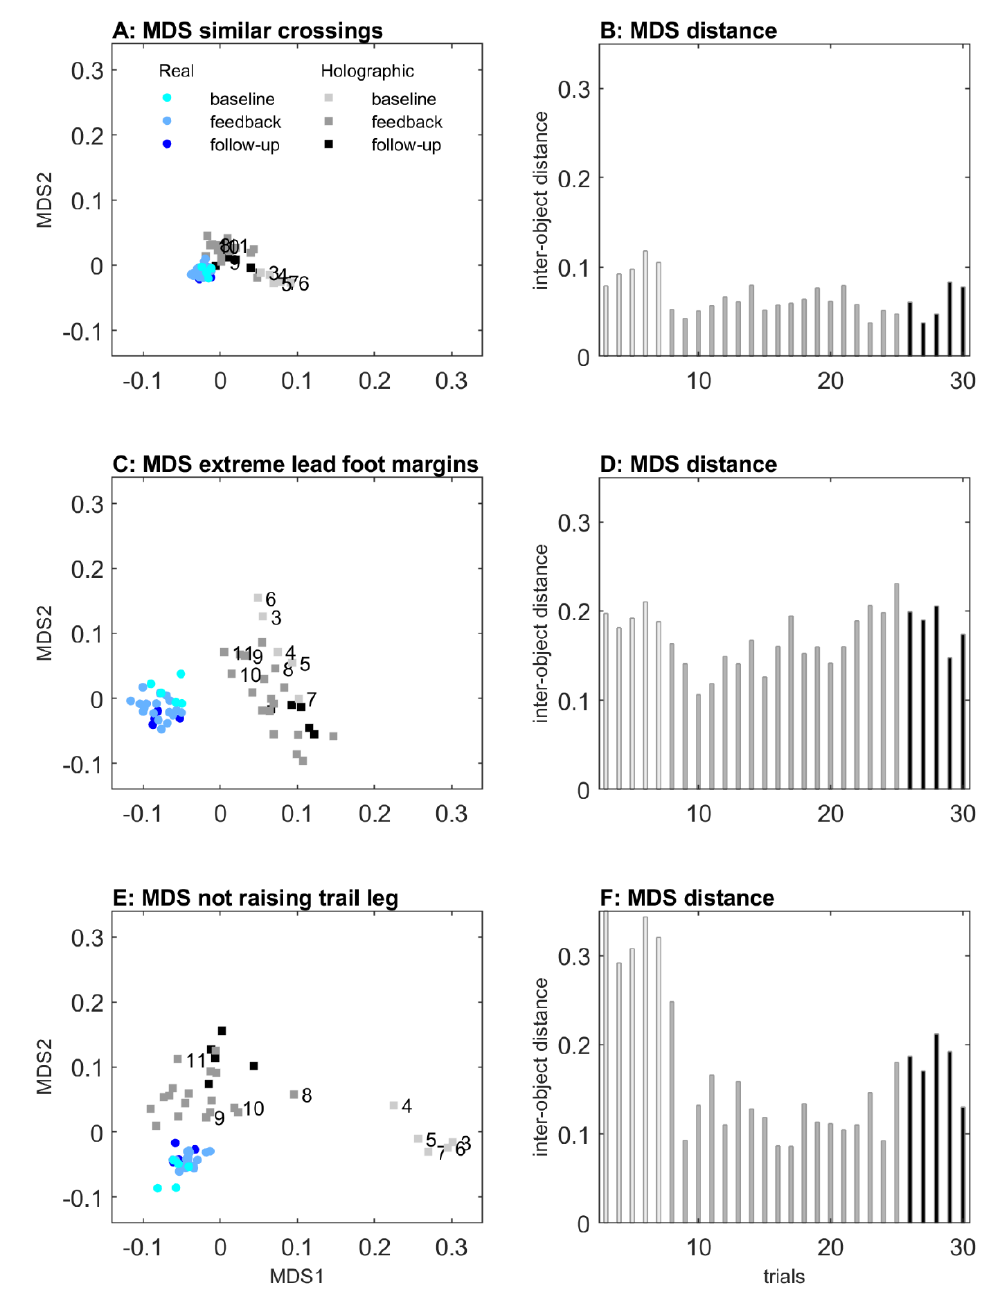
Figure 7. MDS representation of 2 blocks of trials 3 to 30 with real and holographic obstacles, derived from the foot clearances and maximum step heights of both feet from all 12 participants. Panel ( A ) shows participants identified in Experiment 1 as those with similar crossing maneuvers for real and holographic obstacles (participants 2, 3, 5, 6, 9, and 12). Panel ( C ) shows participants identified in Experiment 1 as those with exceptionally high lead-foot crossings (participants 4, 7, and 10), and panel ( E ) shows participants identified as those not raising their trail foot in mixed reality (participants 1, 8, and 11). Each trial object is represented by its trial number and obstacle type (real obstacles: blueish circles, holographic obstacles: grayish squares) and shaded as baseline (trials 3 to 7: brightest color), feedback (trials 8 to 25), and follow-up (trials 26 to 30: darkest color). Panels ( B ), ( D ), and ( F ) show the distances derived from the clearance and maximum step height of both feet, between individual holographic obstacle trials, and the average over all real obstacle trials, again with shades of gray indicating baseline, feedback, and follow-up blocks of